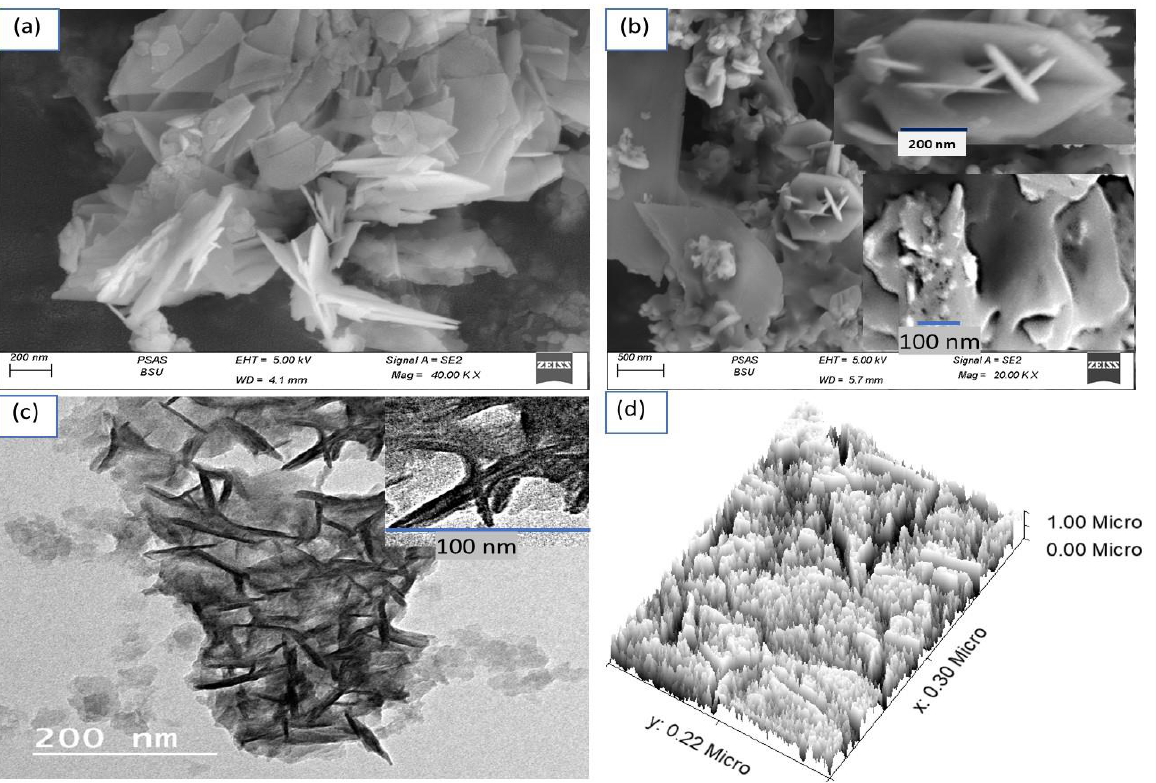
Figure 2. SEM of ( a ) G-C3N4 and ( b ) CoS-Co 2 O 3 /G-C3N4 composite. ( c ) TEM and ( d ) theoretical image of CoS-Co 2 O 3 /G-C3N4 composite.